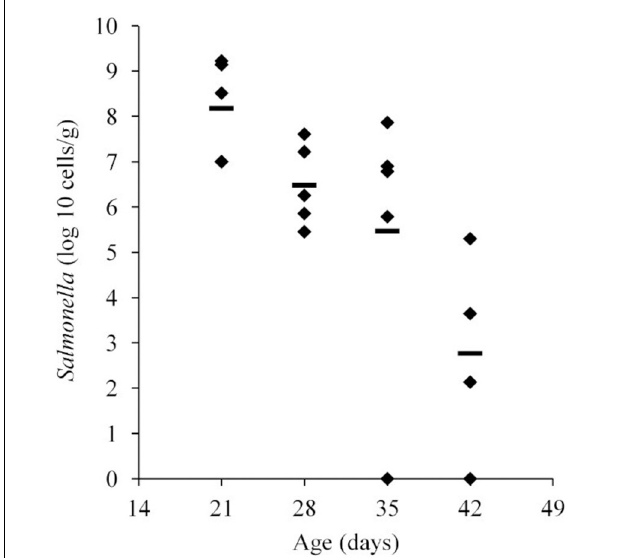
FIGURE 1 | Salmonella abundance in cecal samples collected from chickens at 21, 28, 35, and 42 days old. Chickens were inoculated with 1.1 × 10 6 CFU of Salmonella Typhimurium at 2 days of age. The mean abundance is indicated by the black line.